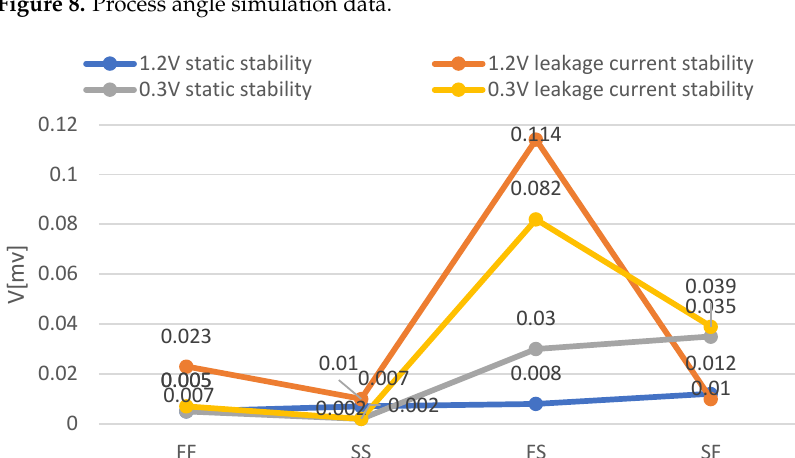
Figure 8. Process angle simulation data.